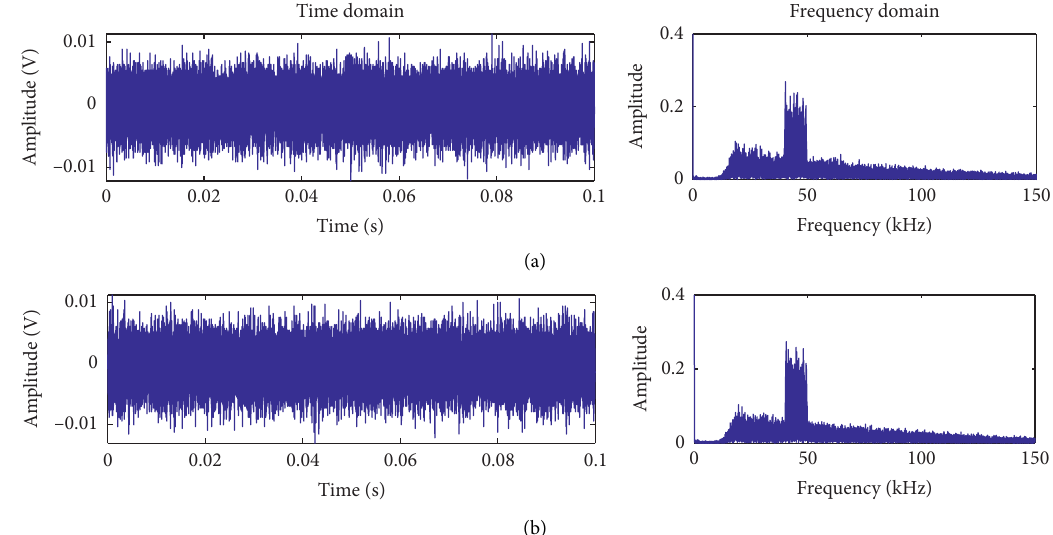
Figure 2: Characteristics in time and frequency domain of leak AE signals captured by PAC AE sensor S9028: (a) environmental noise; (b) 0.5ml/s.